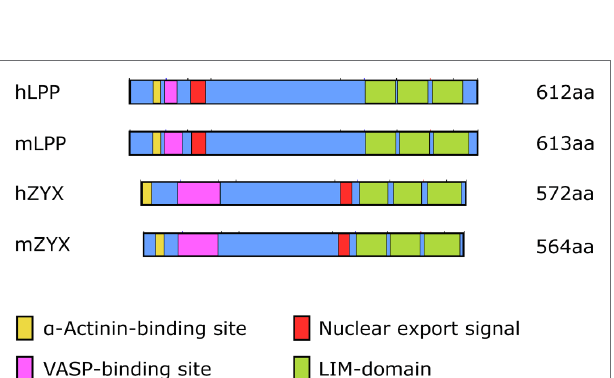
FIGURE 2 | Organizational structure of human (h) and mouse (m) LPP and zyxin proteins depicting the α -actinin and VASP-binding sites close to the N-terminus as well as the three LIM domains close to the C-terminus. The length [number of amino acids (aa)] of the individual proteins is indicated on the right. Note the different localization of the nuclear export signal and the overall difference in length between LPP and zyxin in both